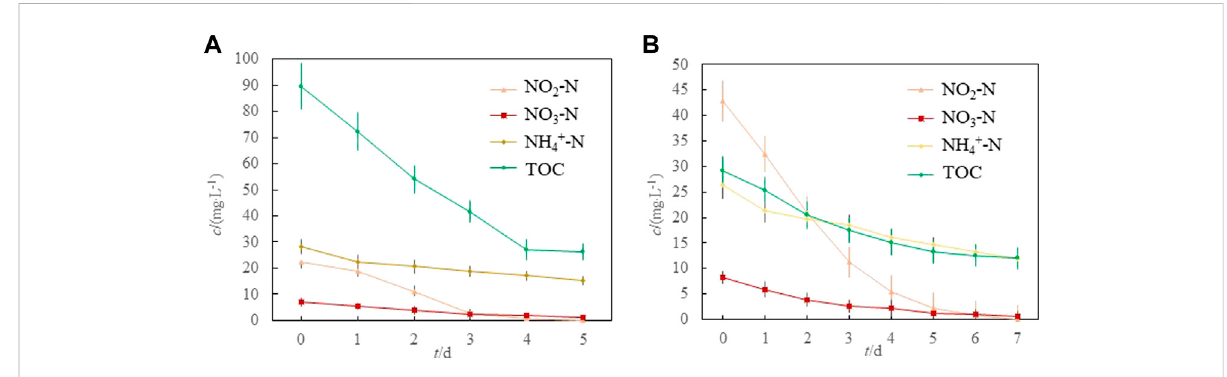
FIGURE 4 The NO 2 − -N, NO 3 − -N, NH 4 + -N, and TOC in denitri fi cation and anammox groups (A) denitrifying group; (B) . anammox